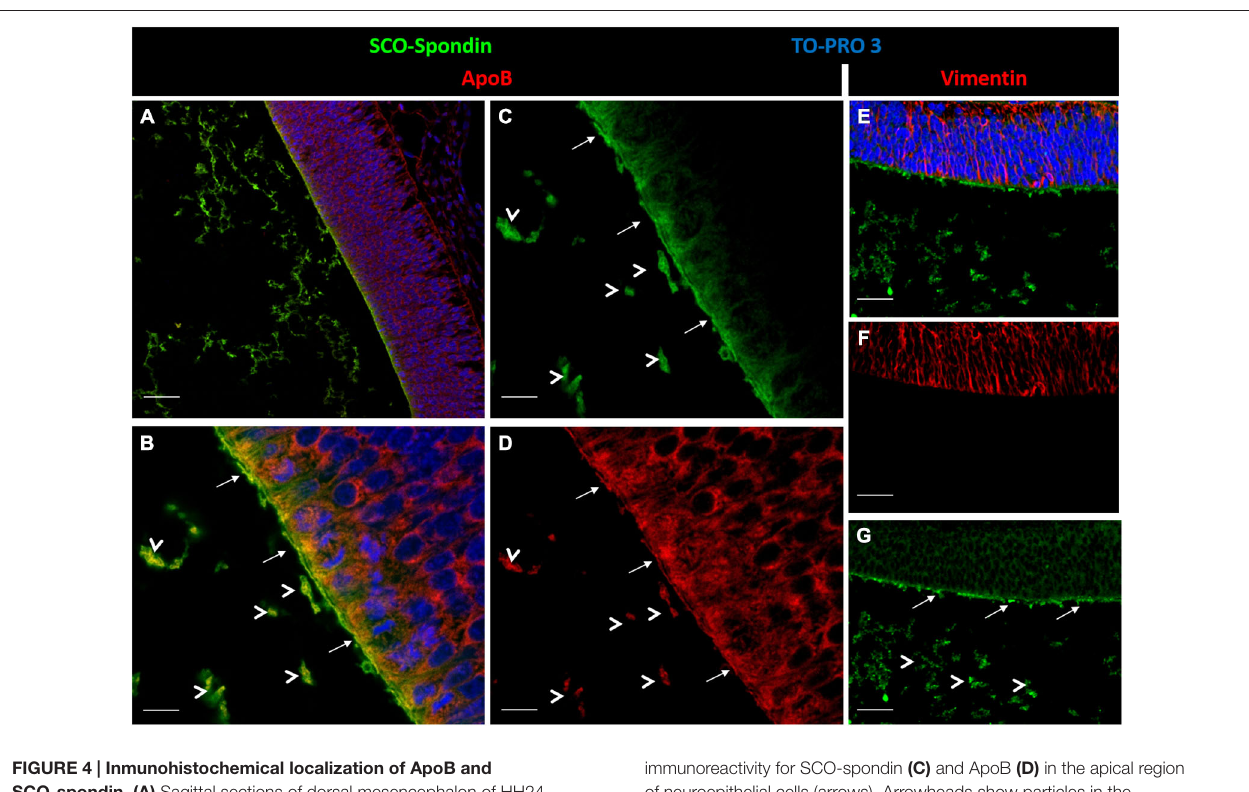
FIGURE 4 | Inmunohistochemical localization of ApoB and SCO-spondin. (A) Sagittal sections of dorsal mesencephalon of HH24 chicken embryos. Immunohistochemistry with antibodies against SCO-spondin (green) and ApoB (red) counterstained for nuclei with TO-PRO-3 (blue). (B–D) Higher magnification of (A) , showing strong